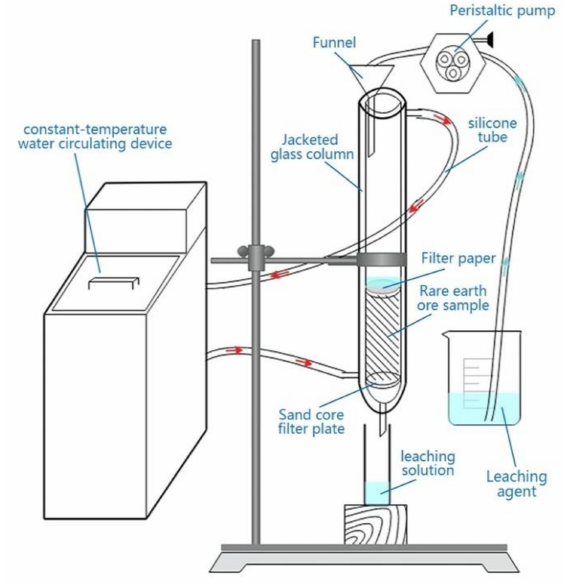
Figure 2. Column leaching